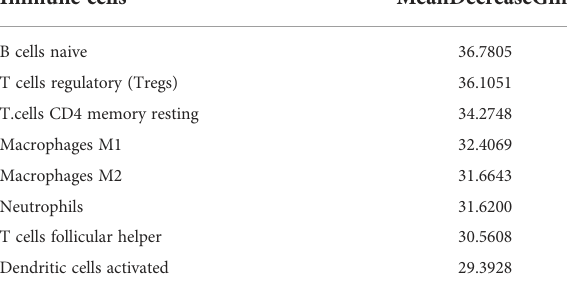
TABLE 2 RF analysis of 8 candidate immune